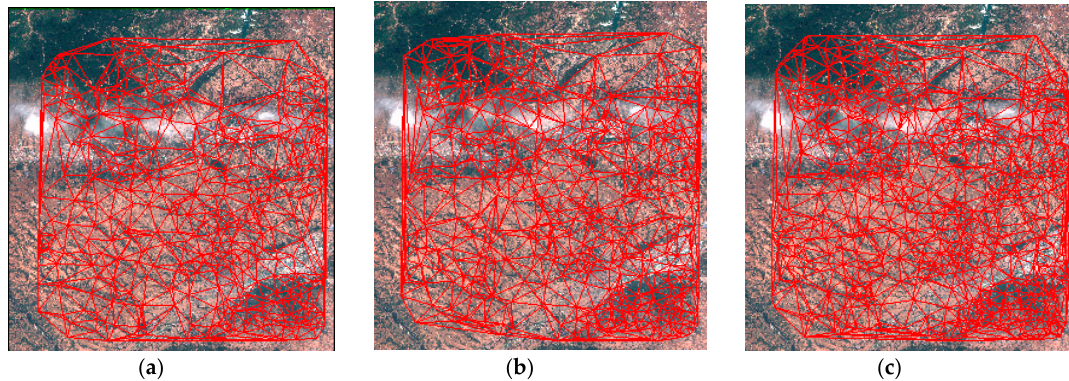
Figure 12. Matching result on Dataset 3. ( a ) CMPs with TIN by Lee’s method. ( b ) CMPs with TIN by Li’s method. ( c ) CMPs with TIN by the proposed method.